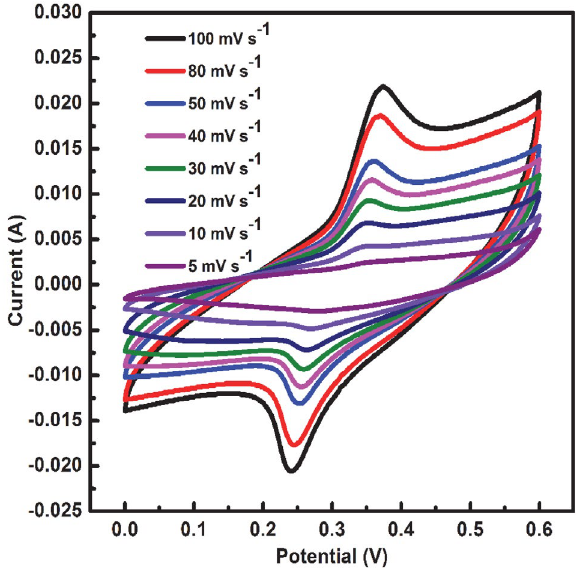
Fig. 8. CV curves of 0.25 mmol Cu 2+ -doped MnO 2 electrode at var- ious scan rates.